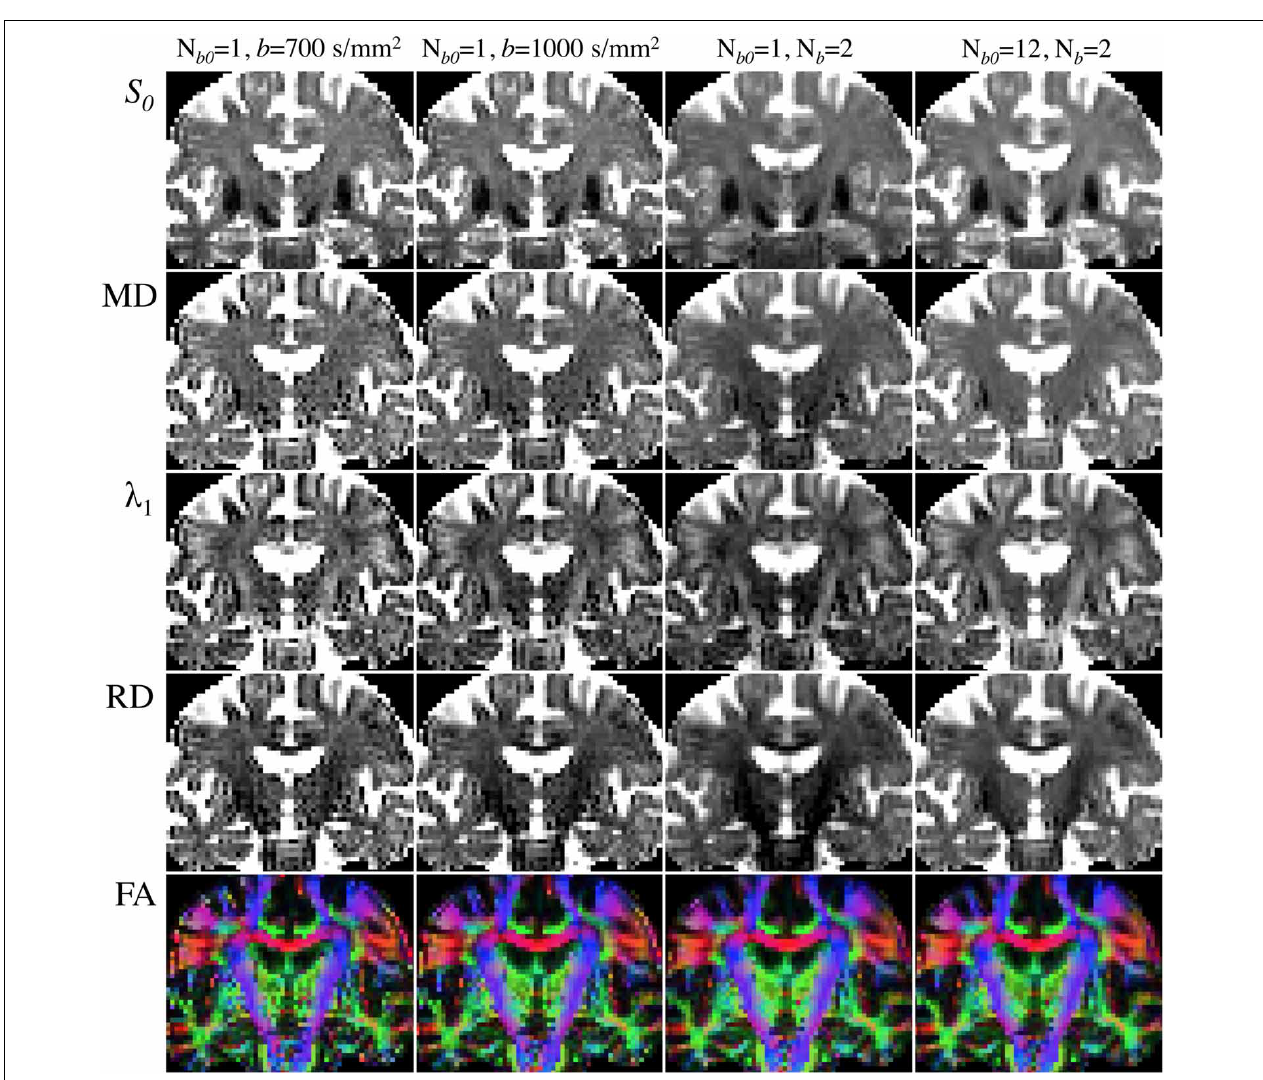
FIGURE 6 | Comparison of DTI parametric maps with different b -value, number of b -values (N b ) and number of b 0 scans (N b 0 ). MRI measurements were performed on a Siemens Verio 3T system (Siemens Medical Systems, Erlangen, Germany)—gradient coils capable of 45mT/m and 200T/m/s slew rate—with a 32-channel phased-array head-coil. Diffusion volumes were acquired using a standard twice-refocused, single-shot EPI pulse sequence: repetition/echo time = 9000/94ms; matrix, 120 × 120; 63 contiguous slices aligned parallel to the anterior commissure/posterior commissure line; voxel size: 2 × 2 × 2mm 3 ; 7/8-phase partial Fourier; bandwidth of 1667Hz/pixel and echo